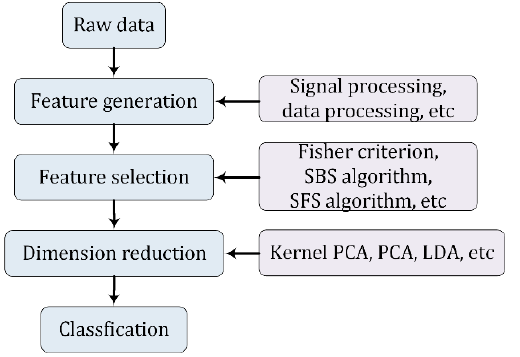
Figure 6. Typical flow chart of data-driven methods for motor diagnosis.